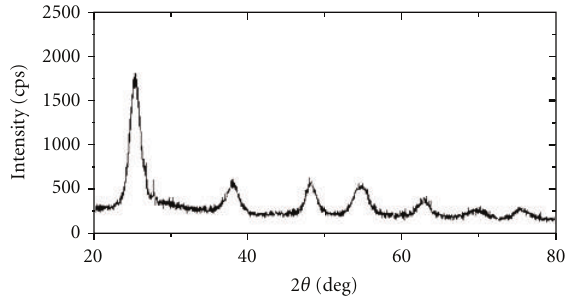
Figure 3: XRD spectra of N-doped mesoporous titania.